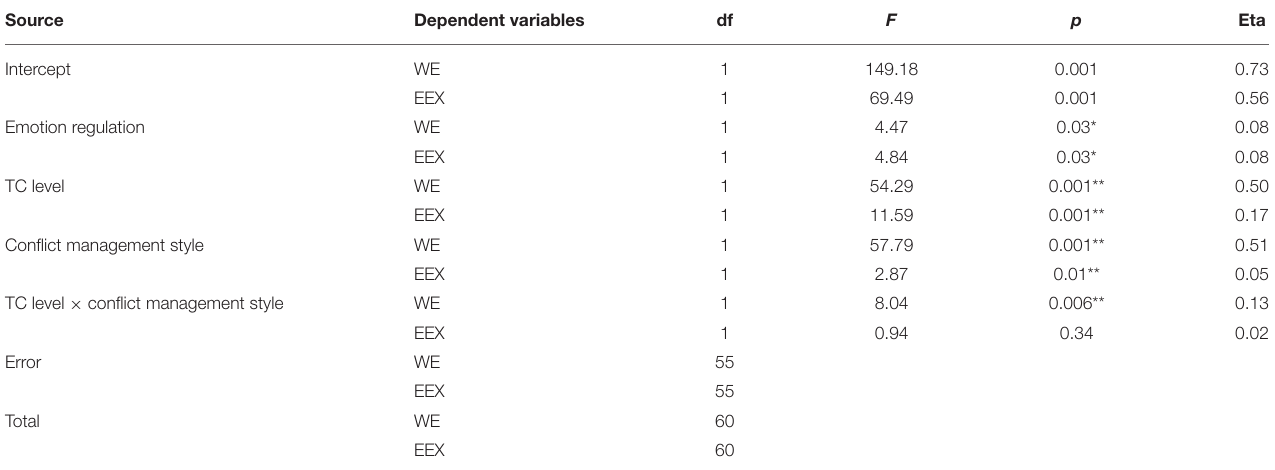
TABLE 8 | Results of MANCOVA: TC intensity level on work engagement and emotional exhaustion.